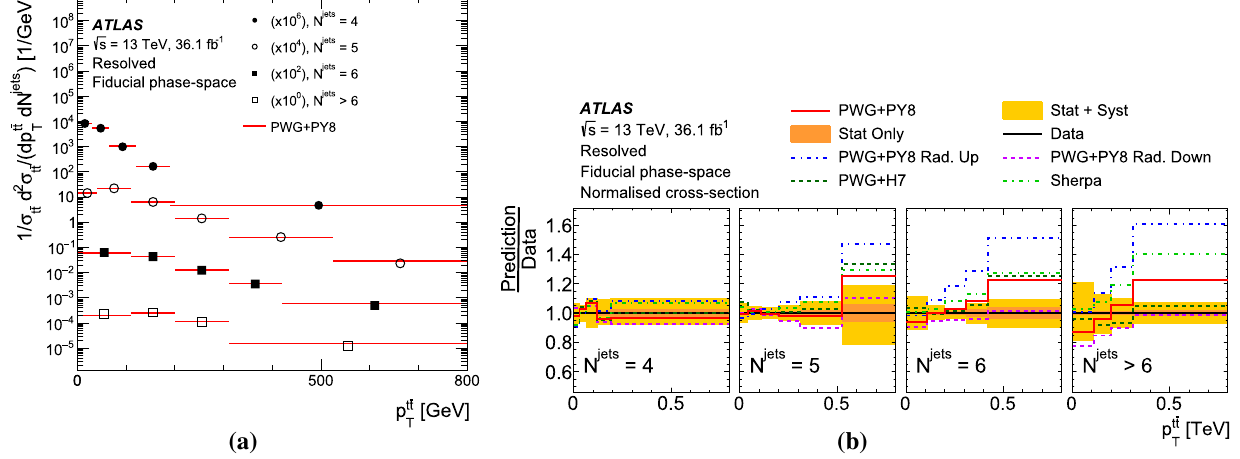
Fig. 32 a Particle-levelnormaliseddifferentialcross-sectionasafunc- tion of p t ¯ t in bins of the jet multiplicity in the resolved topology com- T pared with the prediction obtained with the Powheg + Pythia8 MC